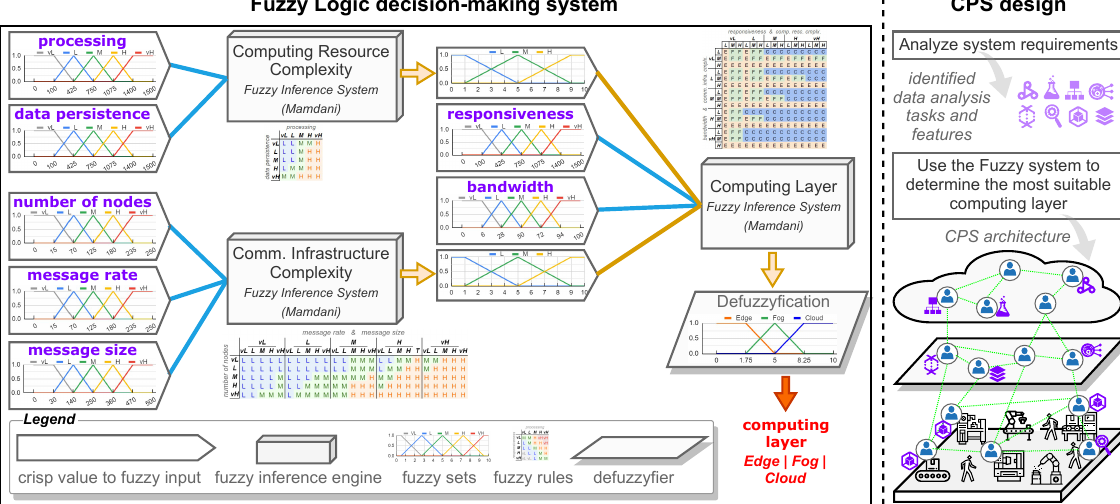
Figure 12. Overview of the fuzzy logic decision-making system to support system engineers in designing decentralized data analysis in